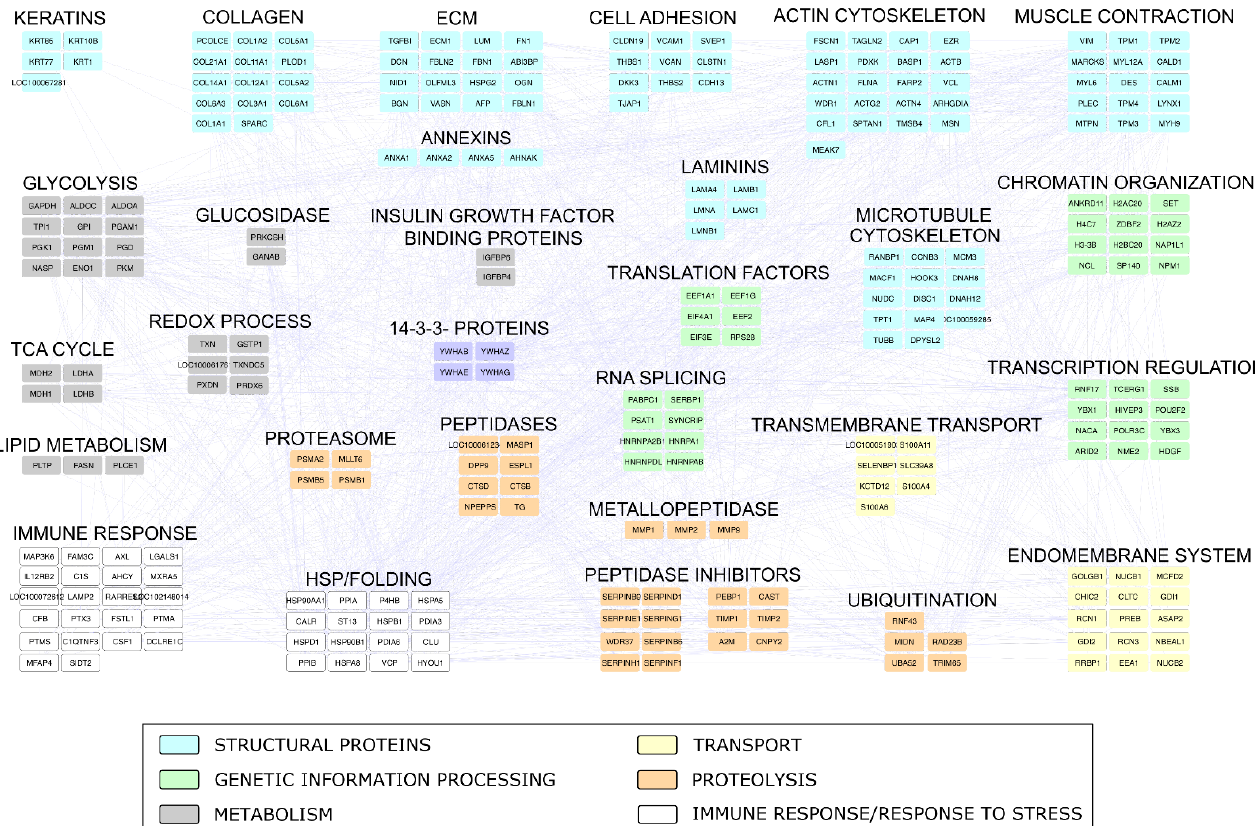
Figure 9. Equus caballus PPI network reconstructed by homology with Homo sapiens. The network was built by STRING Cytoscape APP starting from proteins secreted by mesenchymal stem/stromal cells and identified at least two out of seven replicate